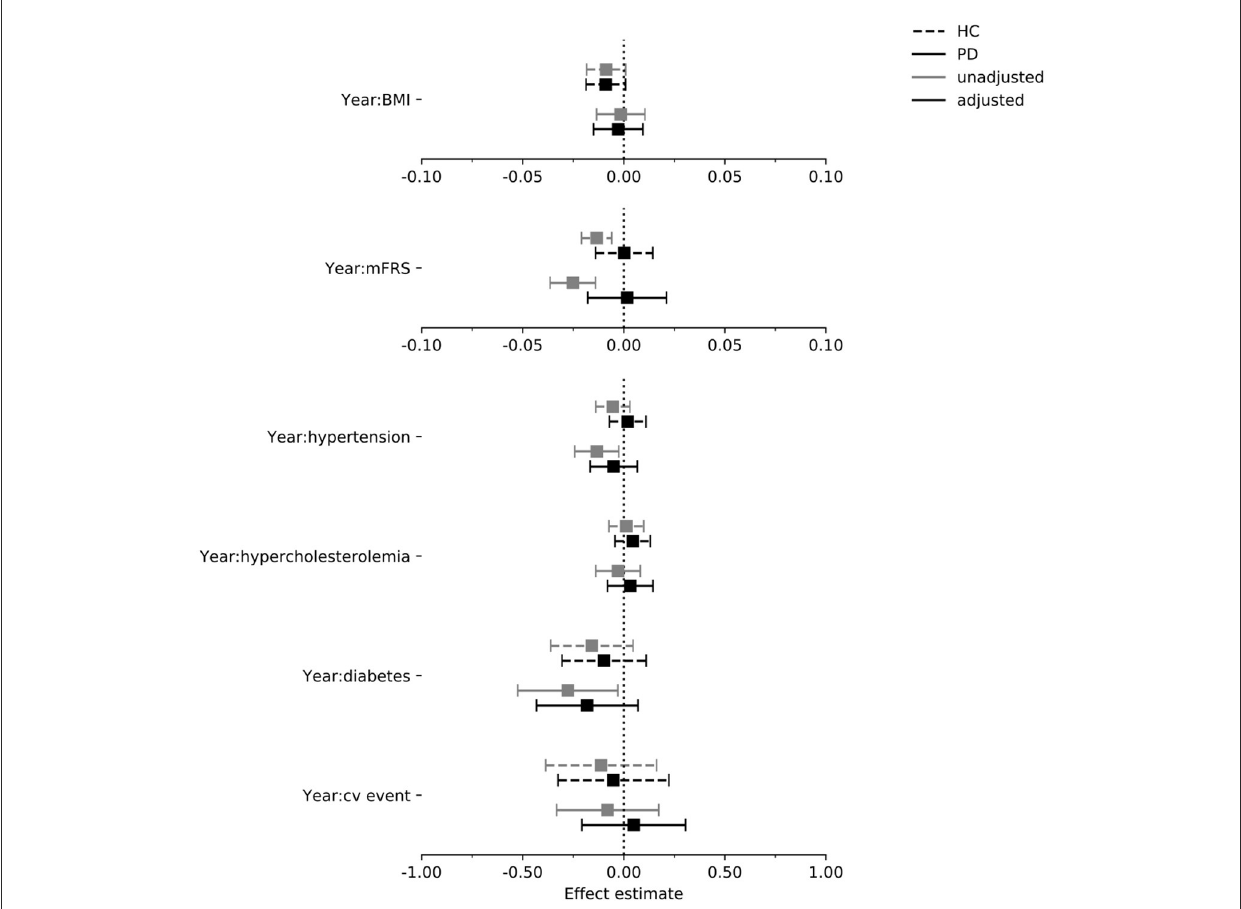
FIGURE4 Estimated effect of each exposure on the rate of change in MoCA per year in the PPMI cohort. Intervals are 95% confidence intervals. mFrs, modified Framingham risk score; BMI, body mass index; cv, cardiovascular; HC, healthy control; PD, Parkinson’s